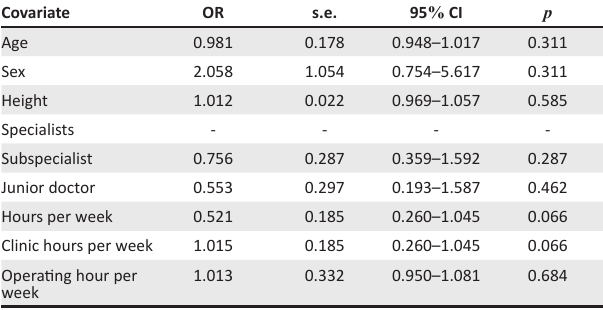
TABLE 4 : Logistic regression model using a backward regression approach. Covariate